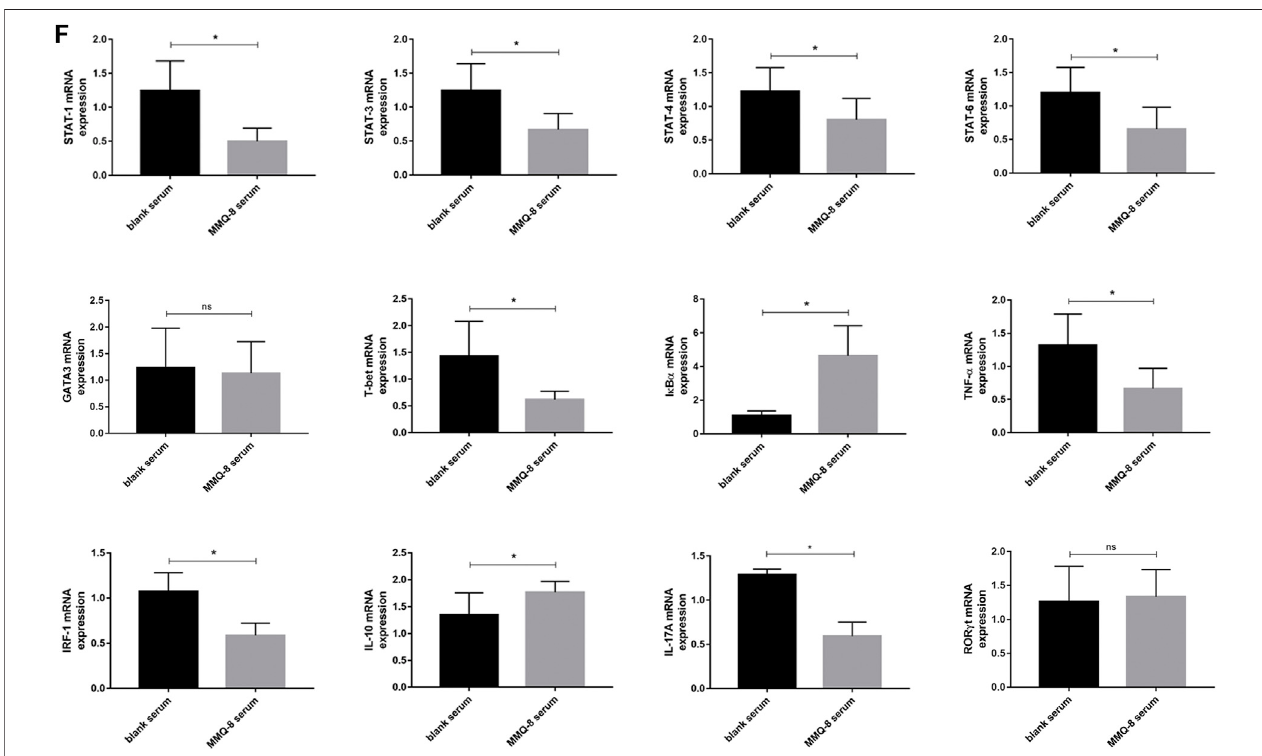
FIGURE6| MMQ-8treatmentsigni fi cantlydownregulatedmRNAlevelsoftheTNFsignalingpathway,Th1andTh2celldifferentiationsignalingpathway,andTh17 cell differentiation signaling pathway. (A) Heat map depicts the expression of 35 downregulated genes regulated by MMQ-8 related to immune response and lipid metabolism in each group. (B) There are 20 KEGG signaling pathways concerned with in fl ammation that were signi fi cantly enriched in MMQ-8 downregulated genes ( p < 0.05). (C) The top 20 KEGG signaling pathways were enriched in the downregulated genes of ST treatment. The KEGG pathways of interest are marked in a red box. (D) The in vitro experimental protocol of MMQ-8 serum treated CTLL-2 cells. (E) The inhibition rate of CTLL-2 cells incubated with different concentrations of MMQ-8 serum. (F) The treatment of MMQ-8 serum inhibited the relative mRNA levels of Th1, Th17 cell differentiation, and the TNF signaling pathway in vitro . We detected mRNA levels of STAT1, STAT3, STAT4, STAT6, GATA3, T-bet, I κ B α , TNF- α , IRF-1, IL-10, IL-17A, and ROR γ t. Data are presented as means ± SD, n = 3, * p < 0.05, ** p <